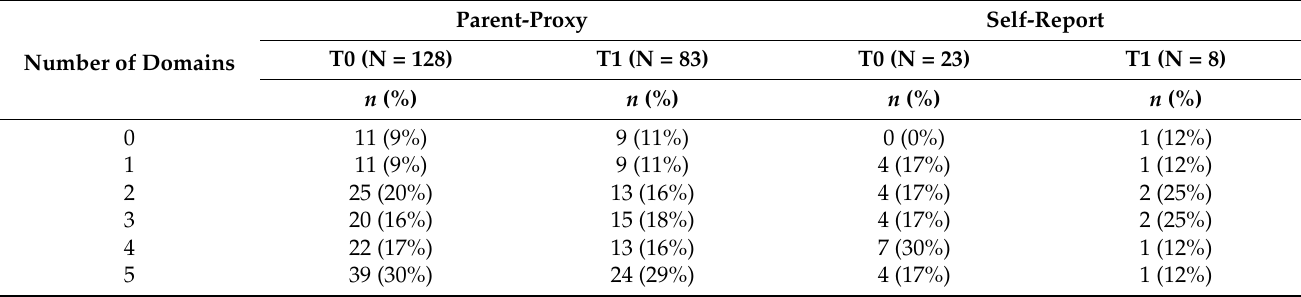
Table 4. Number of domains in which patients experience at least some problems (some or a